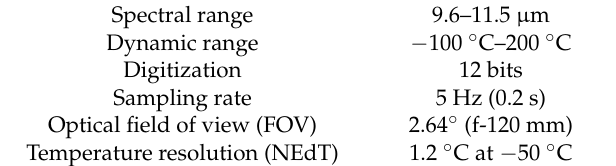
Table 1. The specification of IRT (Heitronics KT 19.85II) used for the current study. Here, the temperature resolution represents a measure of the detector sensitivity, equivalent to the noise equivalent delta-temperature (NEdT) at the given observation conditions [17]. Here, the value given in the table is for the case with the emissivity of 1 and the response time of 0.3 s.